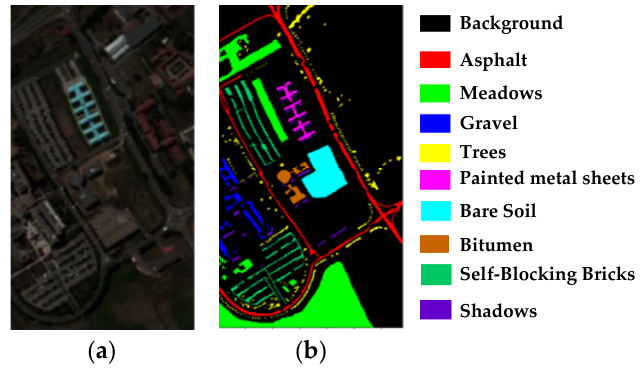
Figure 6. Pavia University Data Set (( a ) False-color map; ( b ) Ground-truth map).